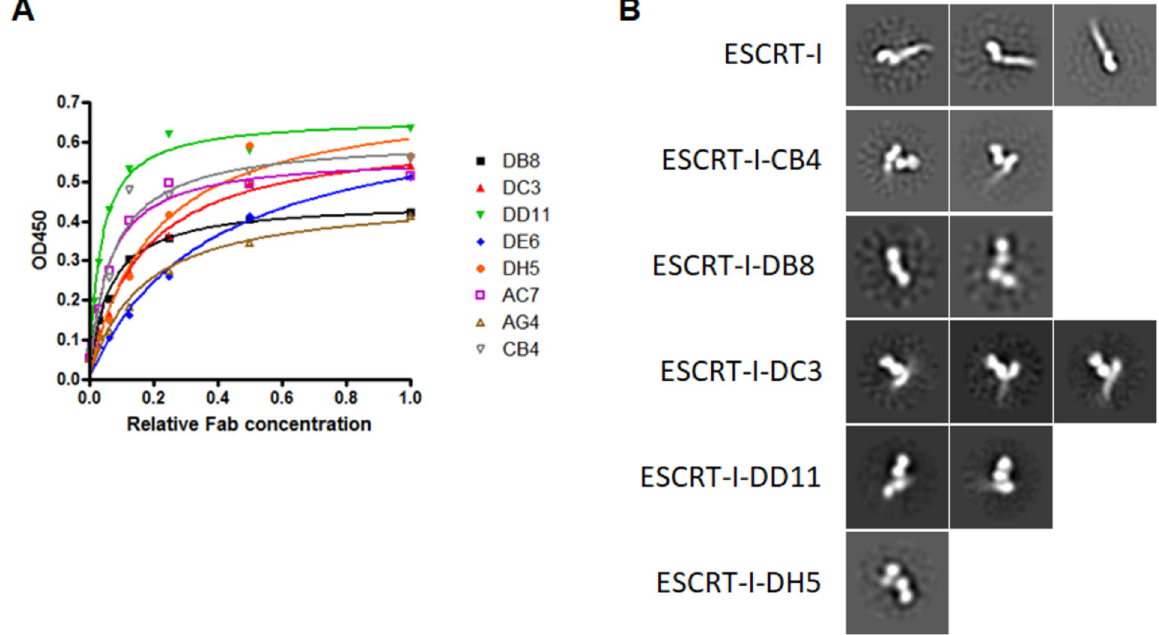
Fig 5. Selection of Fabs against ESCRT-I. A . Representative qualitative ELISA of the 8 selected Fabs. Serial dilutions of supernatant of independent clones were added to wells coated with biotinylated ESCRT-I complex. The non-diluted supernatant was considered a relative Fab concentration of 1. The Fab bound to the wells was detected with anti-myc antibody conjugated to peroxidase. B . Representative negative stain 2D class averages of ESCRT-I complex with and without specific Fabs.